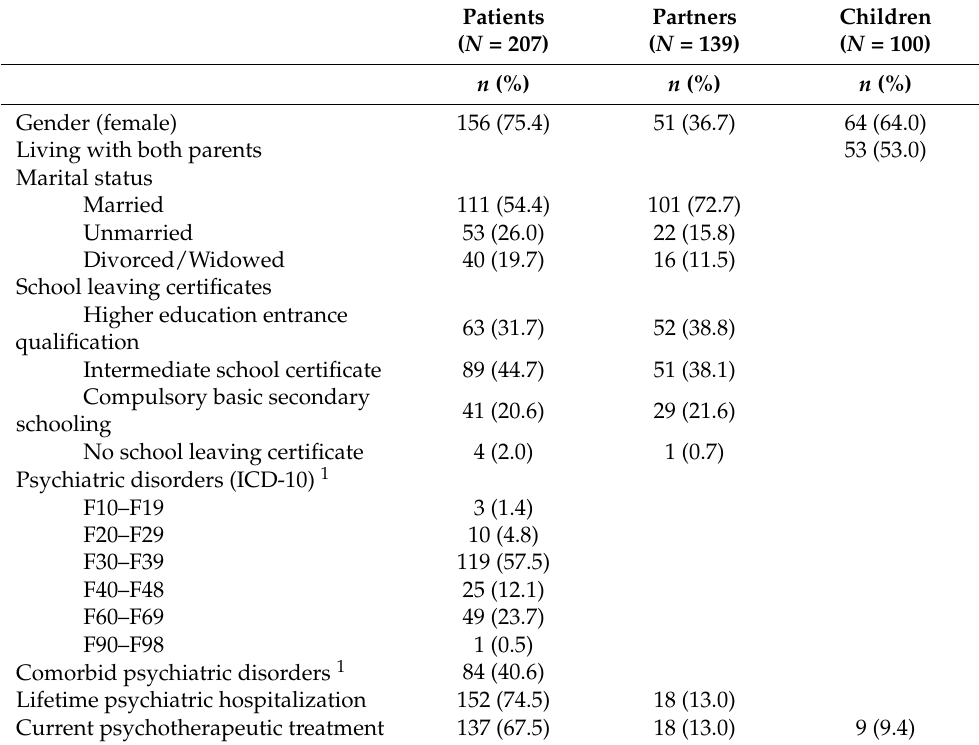
Table 1. Demographic and clinical characteristics of patients, partners, and